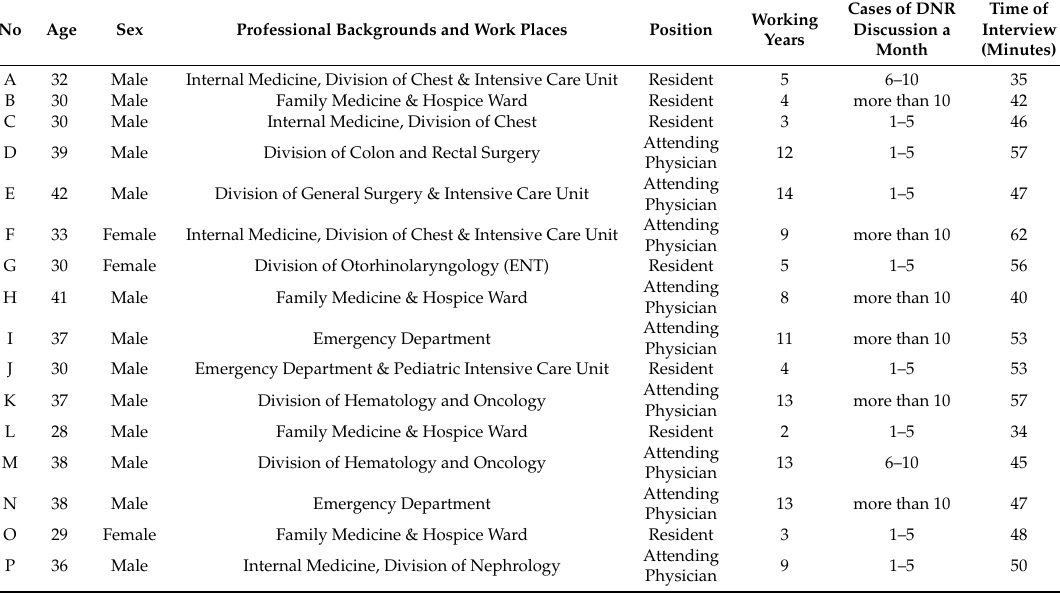
Table 1. Demographic and work characteristics of the